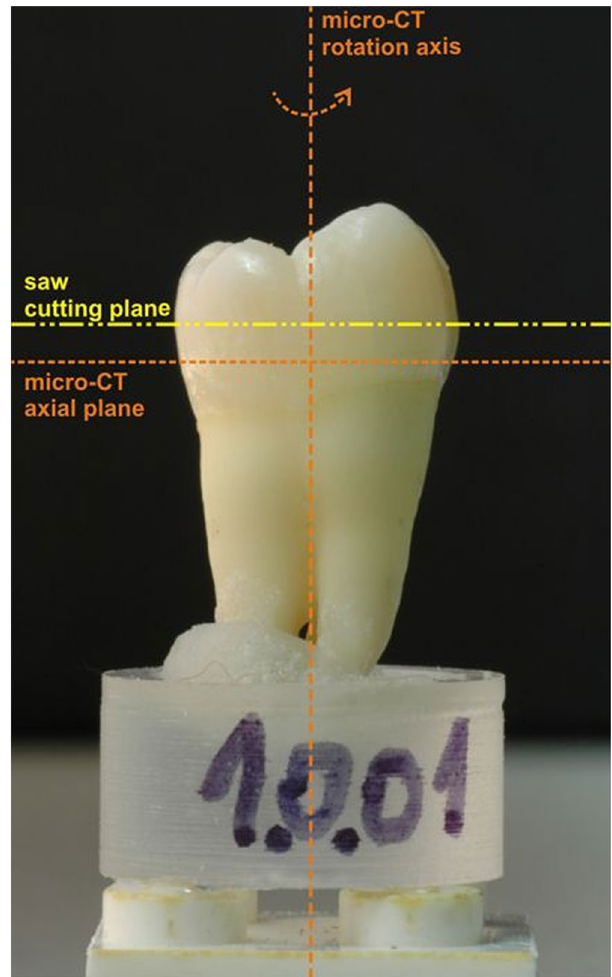
Figure 1. Sample tooth mounted on the custom designed